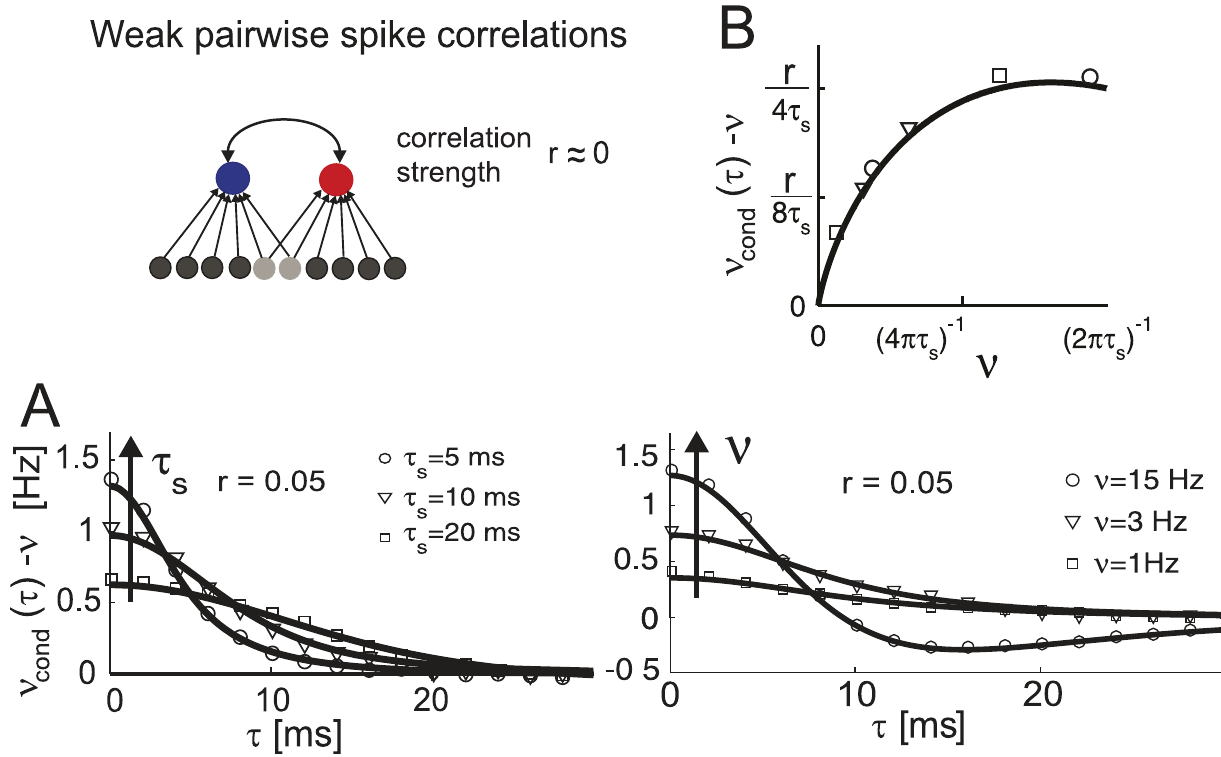
Figure 7. Weak spike correlations in the threshold model. (Top) Illustration of spike correlations resulting from common input that are studied in A and B. (A) Cross conditional firing rate n cond ( t ) { n vs. time t in the limit of weak input correlations ( r ~ 0 : 05) . Both neurons have the same voltage = cosh( t = t s ) , firing rate n ~ 5Hz . Fixed firing rate and varying correlation times t s ~ 5,10,20ms (A, left) or fixed correlation correlation function C ( t ) ~ s 2 V time t s ~ 10ms and varying firing rates n ~ 1,3,15Hz (A, right). (B) Peak spike correlation n cond (0) { n as a function of firing rate n . Symbols denote the corresponding peak spike correlations from